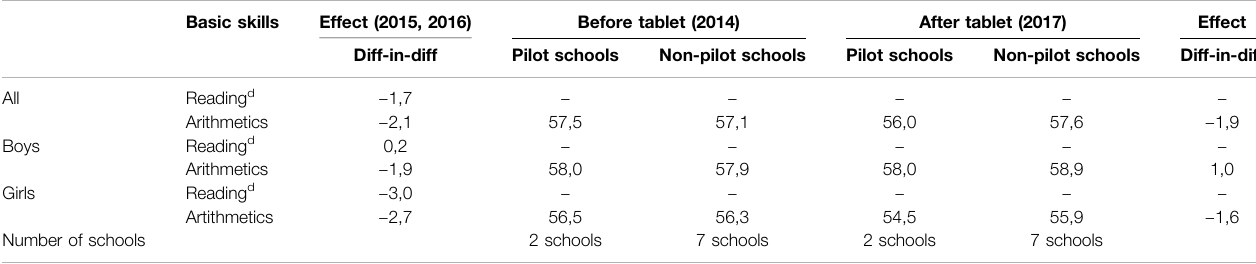
TABLE 5 | Difference-in-difference analysis of average test results, ninth grade (group 1).